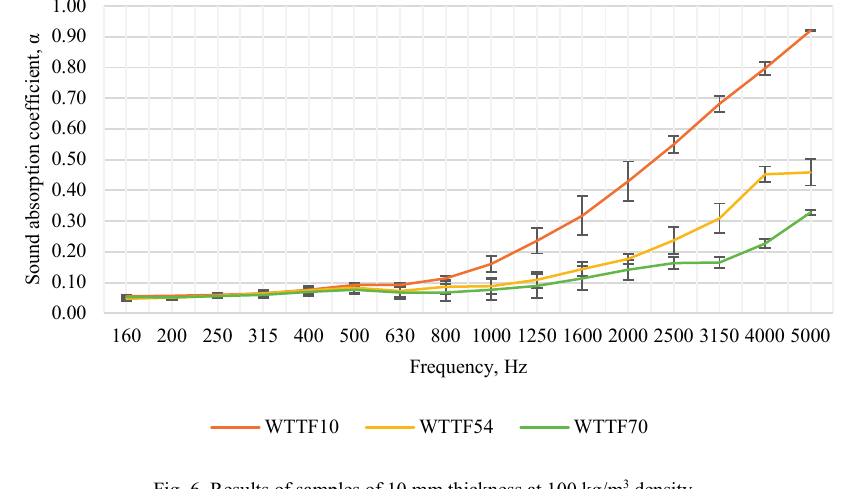
Fig. 6. Results of samples of 10 mm thickness at 100 kg/m 3